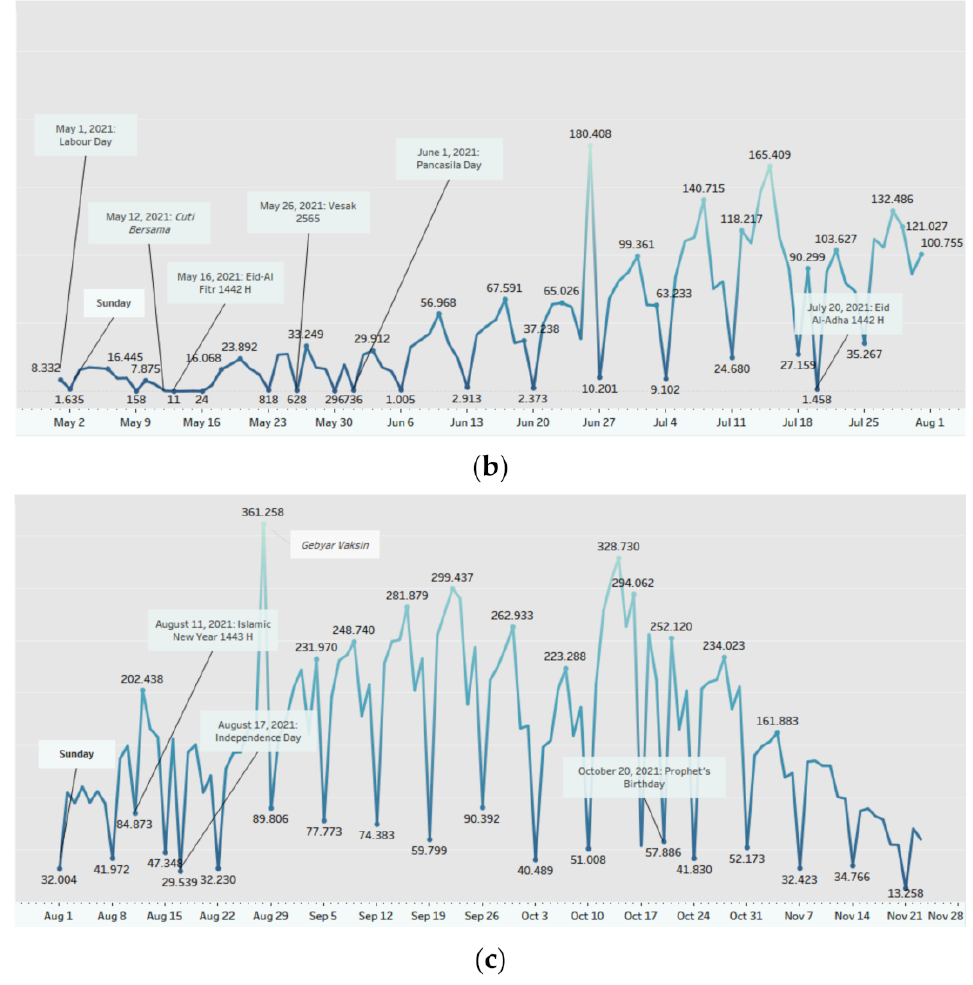
Figure 3. First-dose vaccination trend in West Java: ( a ) January–April 2021; ( b ) May–July 2021; and ( c ) August–November 2021. The marks are labeled by the sum of first-dose vaccination count; the dates shown are labeled by